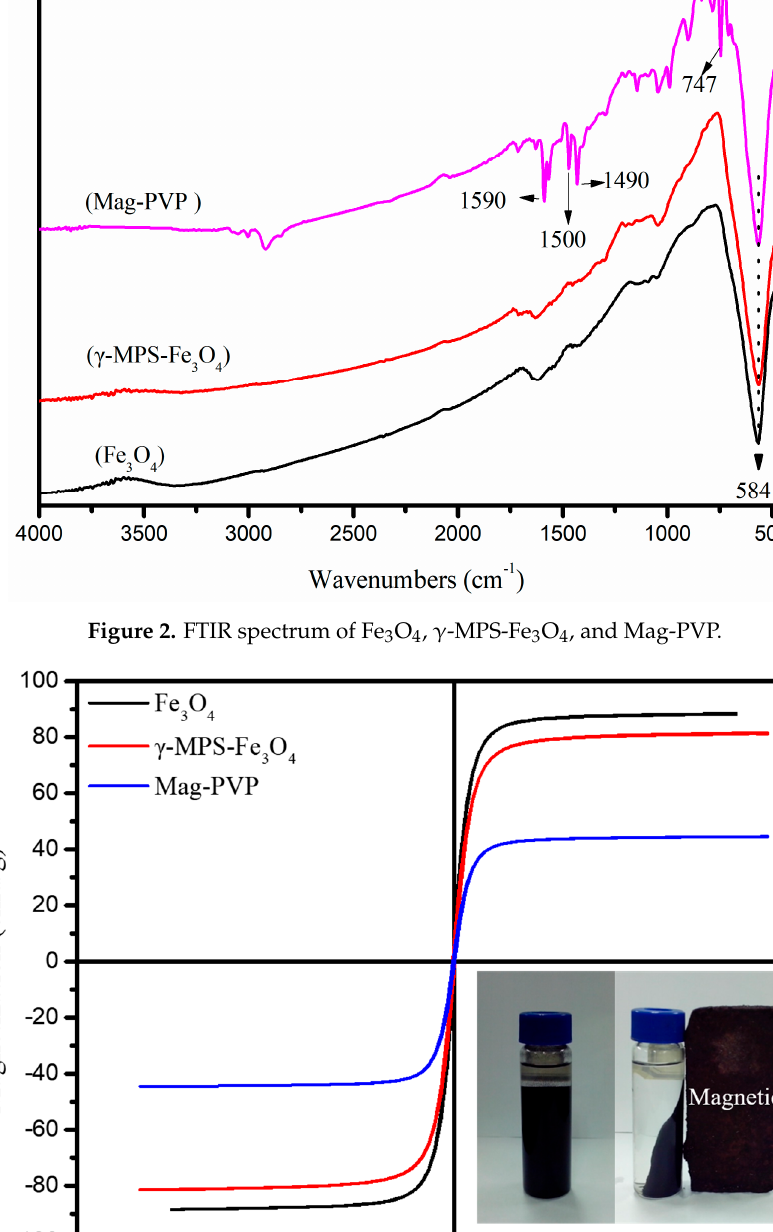
γ -MPS-Fe 3 O 4 , 3 O 4 , and